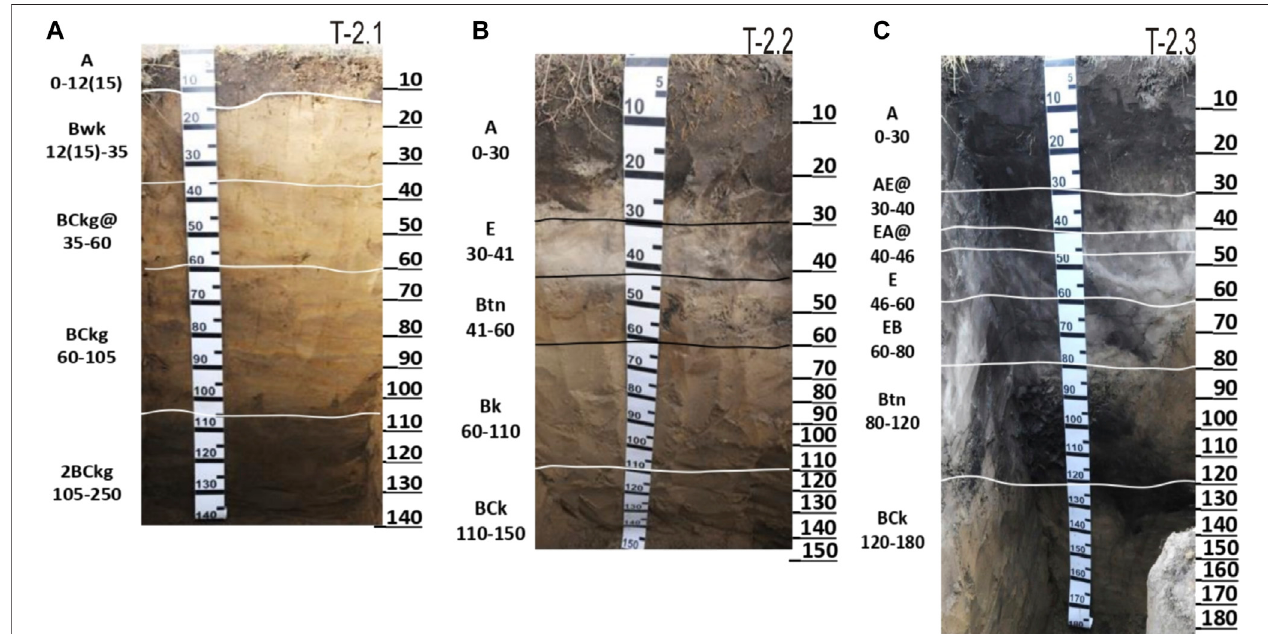
FIGURE 7 | Horizonation of soil pro fi les studied at the Tabaga site: (A) top of byllar, pit T-2.1; (B) slope of byllar, pit T-2.2; and (C) microlow between byllars, pit T-2.3.